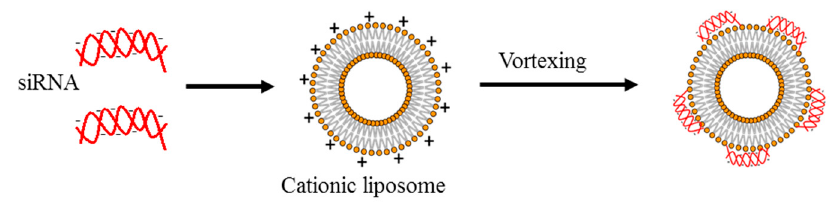
Figure 8. DOPC, DOPE, and DC delivery material developed in Reference [126].